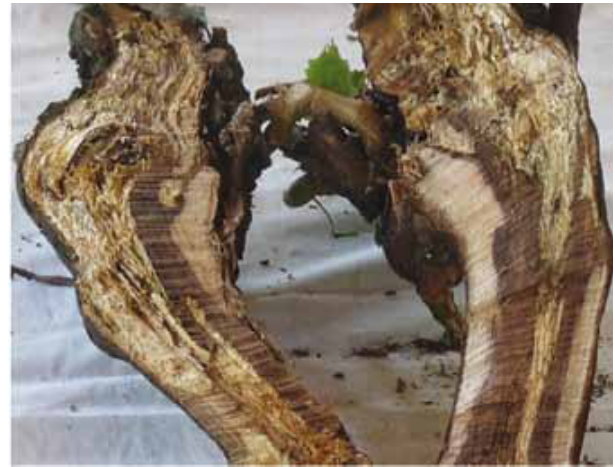
Figure 2: White rot in Chardonnay trunk Photo: Kovács, 2016